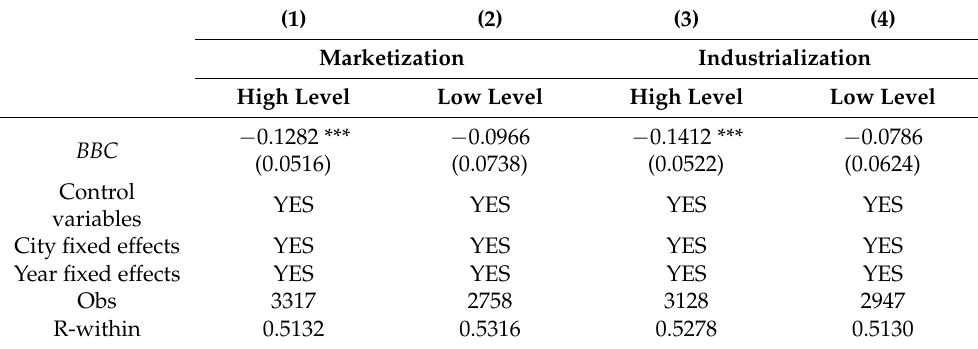
Table 10. Marketization and